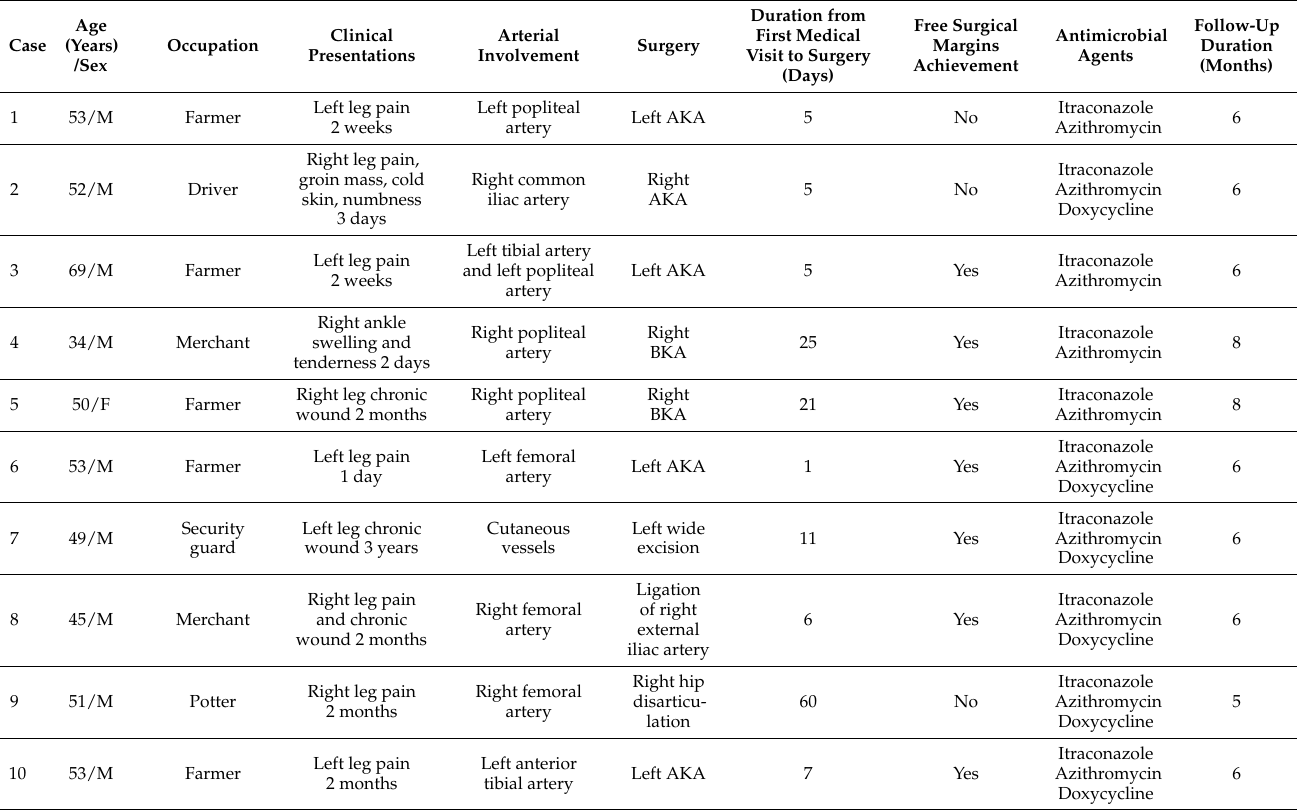
Table 1. Patient characteristics and treatment